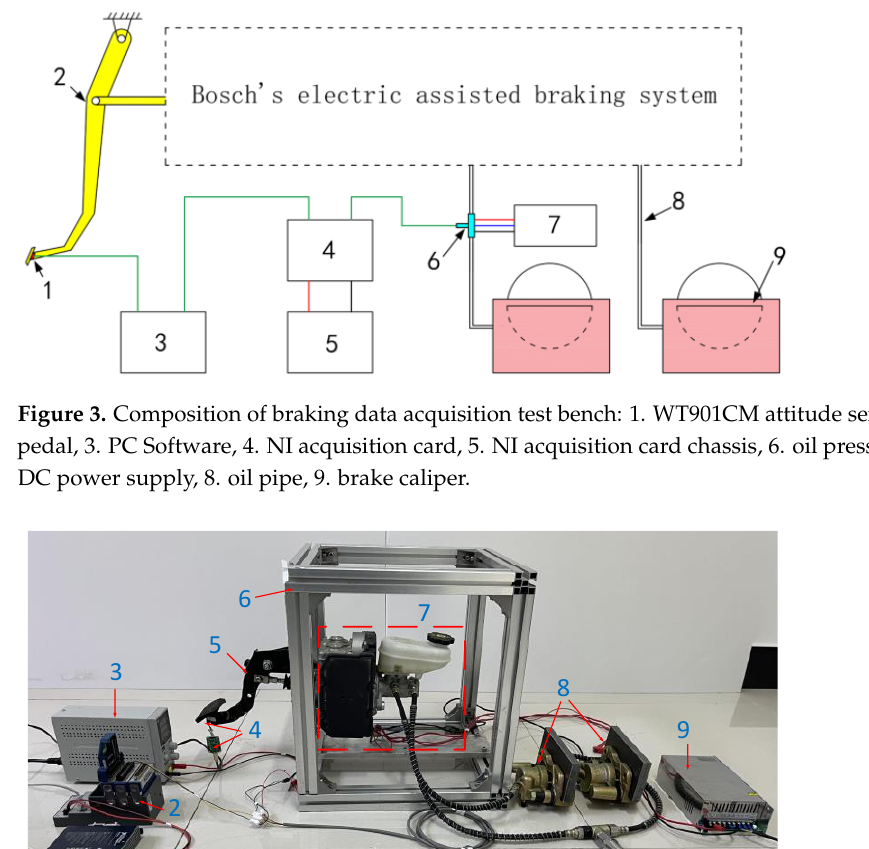
(b) Figure 6. Sampled data under emergency braking conditions: ( a ) Sampled data of actual oil pres- sure and θ . ( b ) Sampled data of ω and α . By analyzing the sampled data, it can be determined that the variation range of ω under emergency braking conditions and general braking conditions are ( − 65,110) and ( − 22.5,14.5), respectively. The variation ranges of α under emergency braking conditions and general braking conditions are ( − 2.5,2) and ( − 0.27,0.7438), respectively, and the varia- tion ranges of both are quite different. When ω > 14.5 or ω < −22.5 , the value of ω has exceeded the variation range of the general braking condition, so the braking condition can be determined by the value of ω . Under both braking conditions, although the varia- tion range of θ is (0,30), when θ > 22 or θ < 22 , the variation ranges of α under both conditions are significantly different. The variation ranges of pedal parameters in the two braking conditions are summarized in Table 1, and the classification algorithm of braking conditions is designed, as shown in Figure 7. The braking conditions classification algorithm is used to classify the data x = (θ,ω,α) . 𝑆 1 is the emergency braking condition, and 𝑆 2 is the general braking condition. The algorithm flow is as follows: Step 1: Is ω ∈ (−0.36,0.38) true? If true, go to Step 2, otherwise, go to Step 3. Step 2: Does x = (𝜃,𝜔,𝛼) satisfy (1) or (2)? (1) θ > 22 and α ∈ (0.1,0.7) (2) θ < 22 and α ∈ (−0.25,0.2) If one of them is satisfied, it belongs to 𝑆 2 . If neither is satisfied, it belongs to 𝑆 1 . Step 3: Is ω > 0.38 true? If true, go to Step 4, otherwise, go to Step 5. Step 4: Is ω > 14.5 true? If true, it belongs to 𝑆 1 , otherwise, determine whether x = (θ,ω,α) satisfies (3) or (4). (3) θ > 22 and α ∈ (0,0.7438)